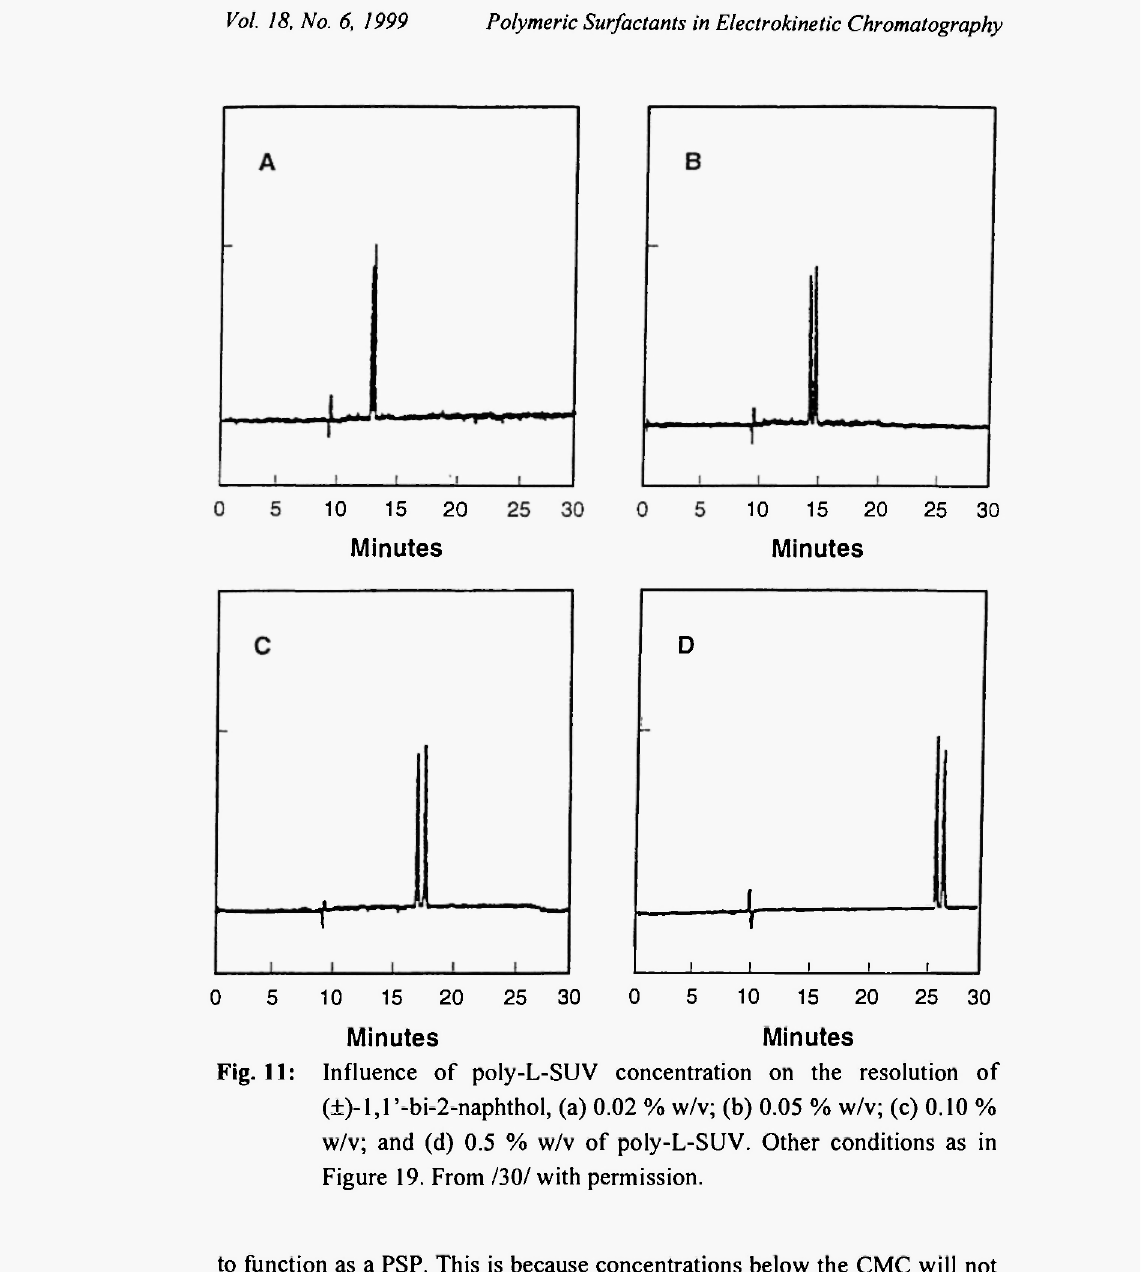
Fig. 11: Influence of poly-L-SUV concentration on the resolution of (±)-1,1 '-bi-2-naphthol, (a) 0.02 % w/v; (b) 0.05 % w/v; (c) 0.10 % w/v; and (d) 0.5 % w/v of poly-L-SUV. Other conditions as in Figure 19. From 130/ with